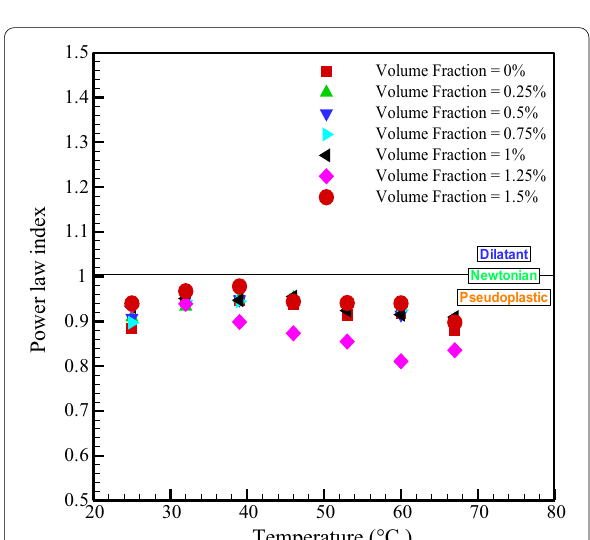
Fig. 5 Changes of power index with temperature in different NPSVFs